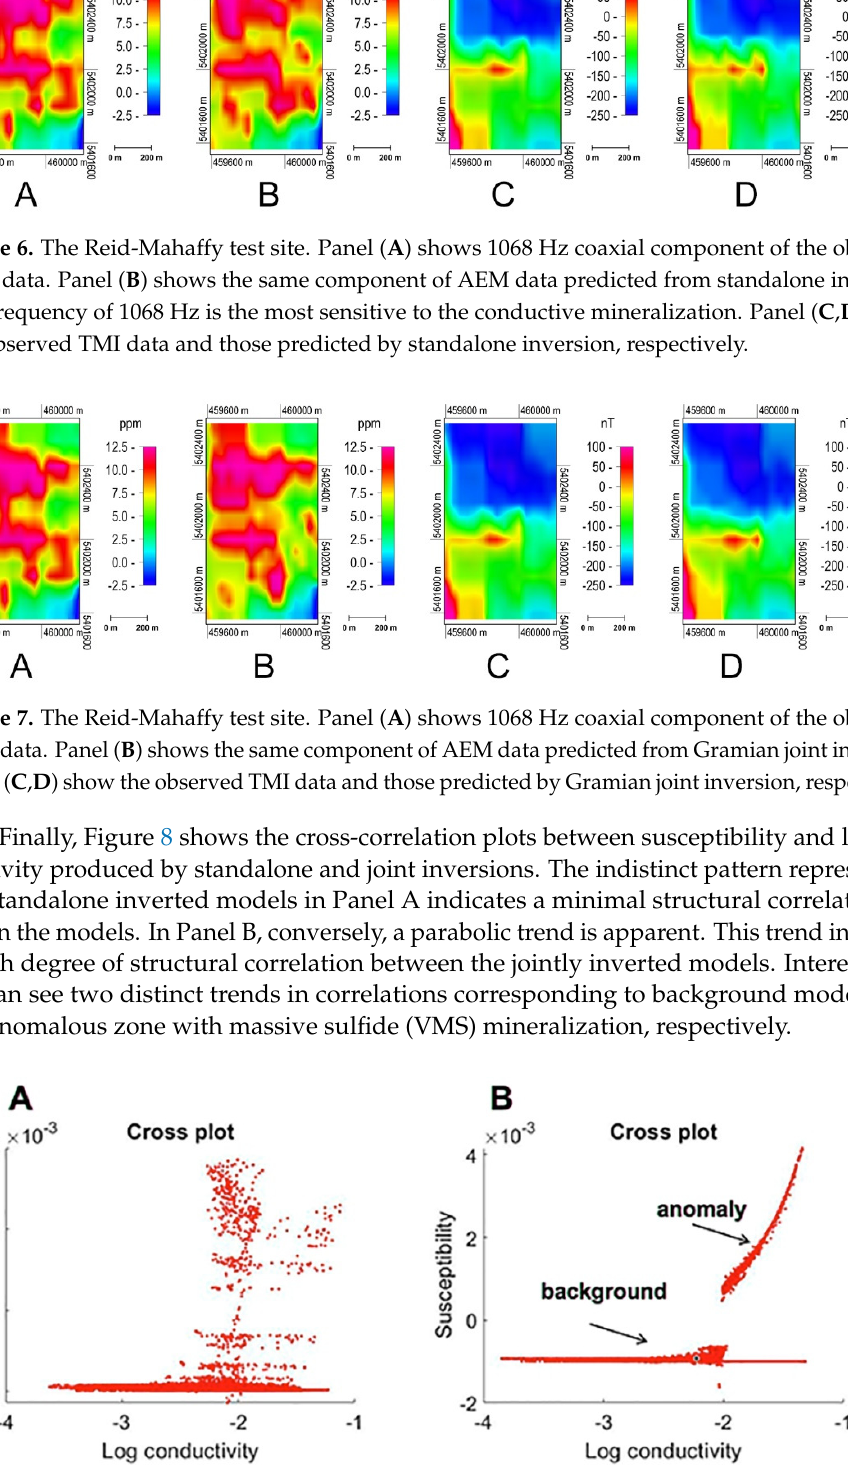
Figure 8. Cross correlation plots between susceptibility and log conductivity. Panel ( A , B ) show the cross plots for the standalone inverted models and jointly inverted models, respectively. The jointly inverted models demonstrate the enhanced structural correlation of the target, expressed in electrical and magnetic properties.